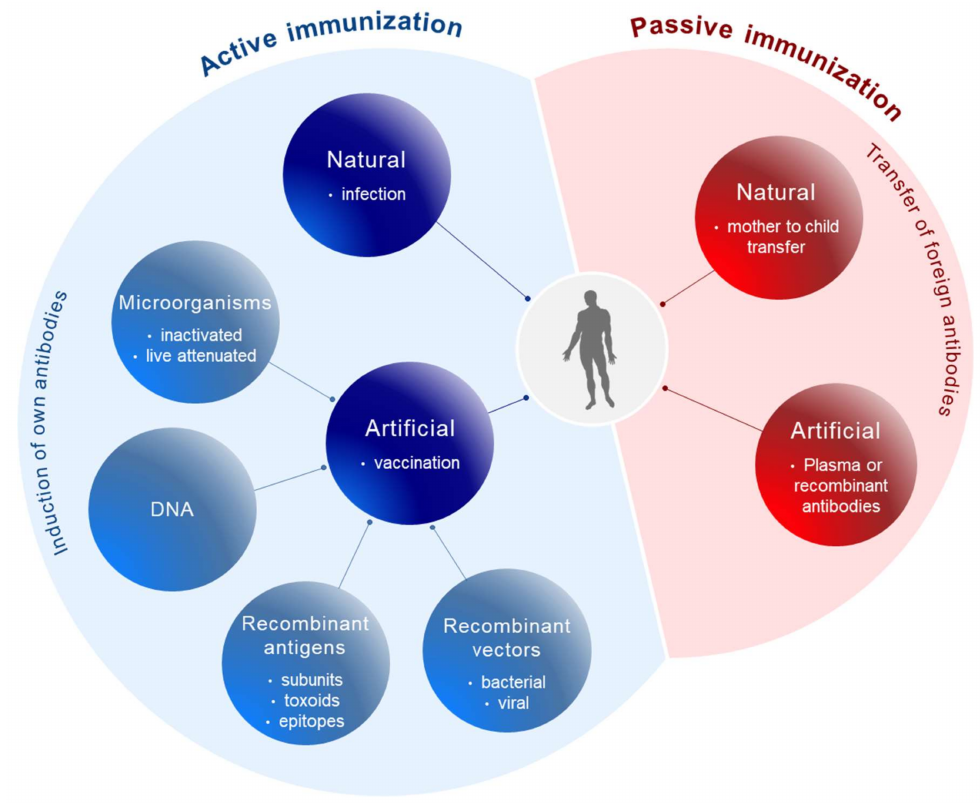
Figure 1. Principles of immunization. Active immunization (blue) involves the induction of the body’s own antibodies either after natural infection or after vaccination with antigen components derived from pathogens. Passive immunization (red) is based on the transfer of foreign antibodies against pathogens into the body for prophylactic or therapeutic